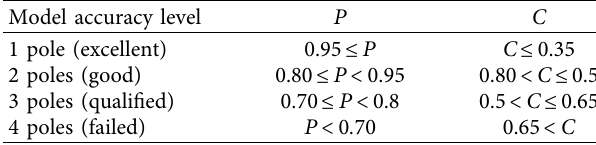
Table 2: Gray forecast accuracy test level